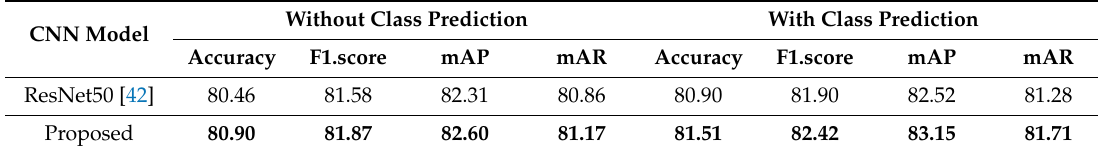
Table 11. Retrieval performance of our proposed model and the second-best model (i.e., ResNet50 [42]) for both methods (i.e., with class and without class prediction) (unit: %).